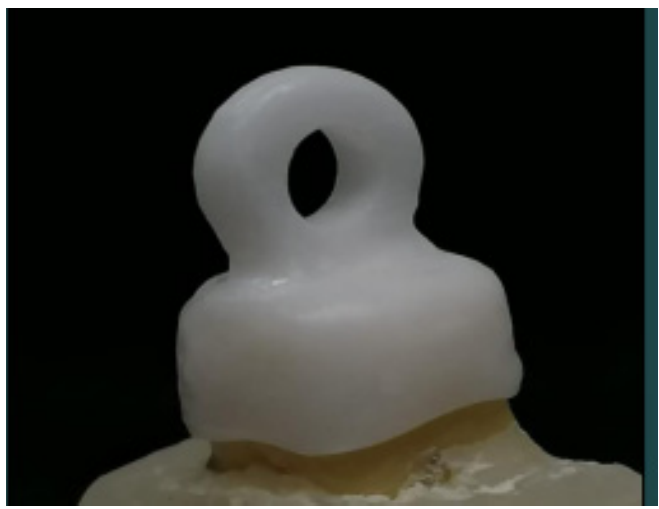
Figure 1. Zirconia coping, designed with a coronal loop (4 mm outer diameter and 2 mm inner diameter) to facilitate tensile